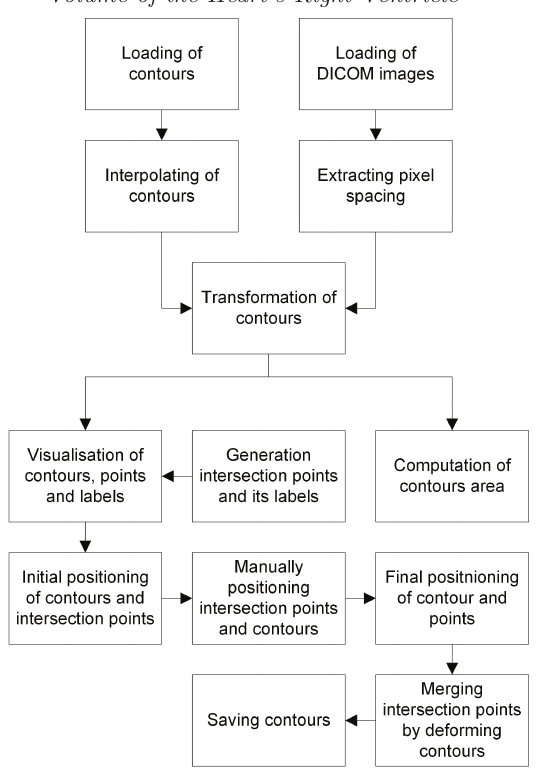
Figure 4. Diagram for semi-automated positioning of